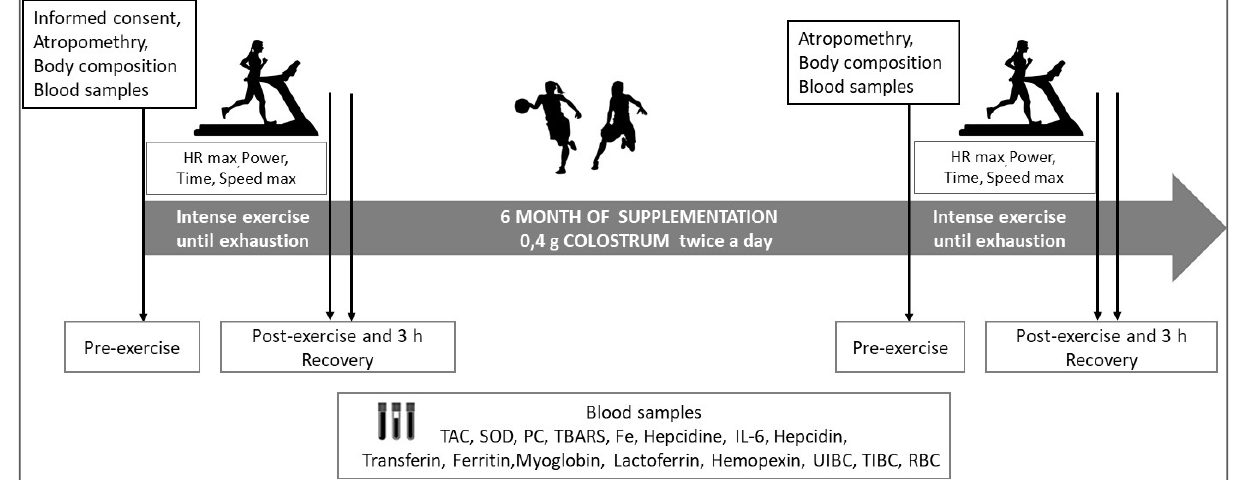
Figure 2. Study design.